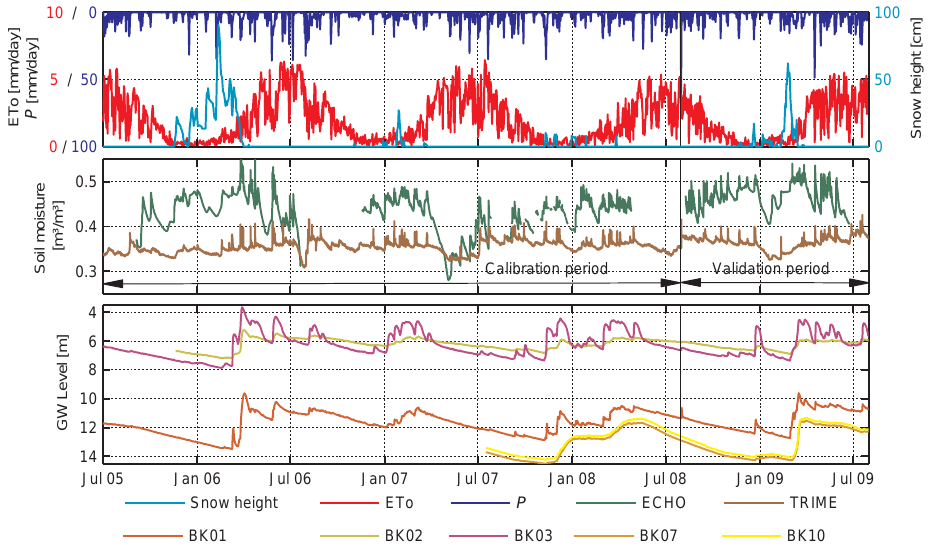
Fig. 3. Time series of input and calibration data. Time series of daily precipitation ( P ), daily reference evapotranspiration (ETo) and snow height (top). Time series of soil moisture (middle) and groundwater data (bottom).